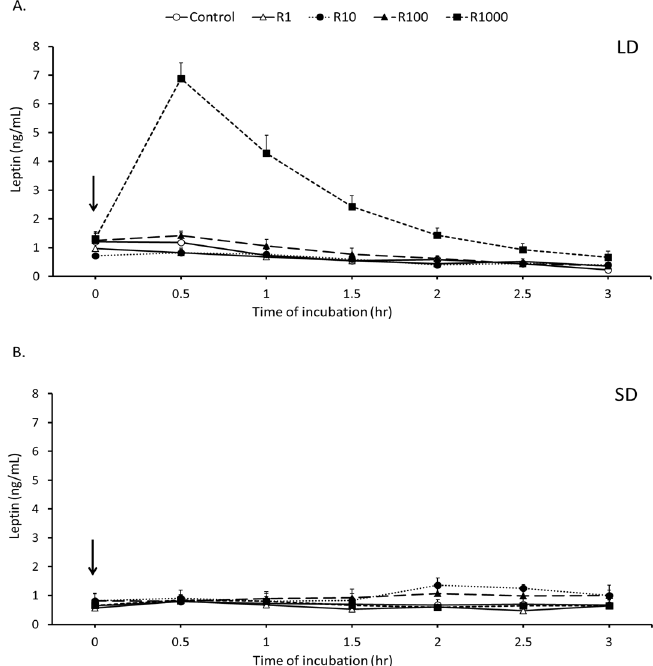
Figure 2. Medium leptin concentrations. Mean concentrations ( ± SEM) of leptin in media collected during a 3.0 h incubation of ovine perirenal adipose tissue explants obtained during long-day (LD) (panel A) and short-day (SD) (panel B) photoperiods. Adipose tissue explants were incubated with medium containing bovine recombinant resistin (1, 10, 100, or 1000 ng / mL) or medium without hormonal supplementation (Control). Arrows denote 0 (control) h or rbresistin treatment.